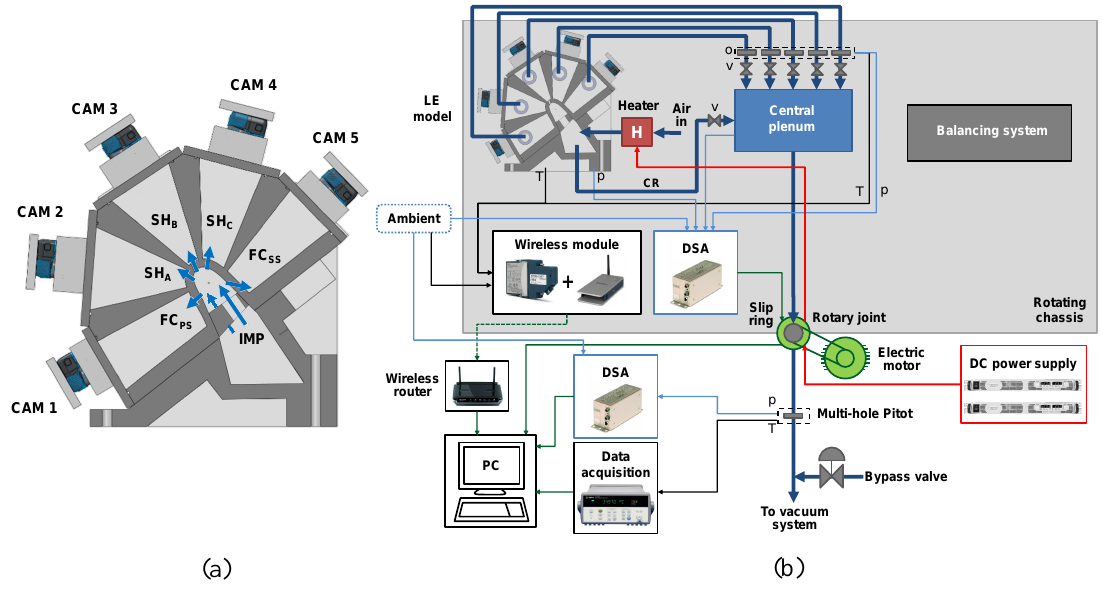
Figure 2. ( a ) Cross-section of the cooling geometry and ( b ) scheme of the test